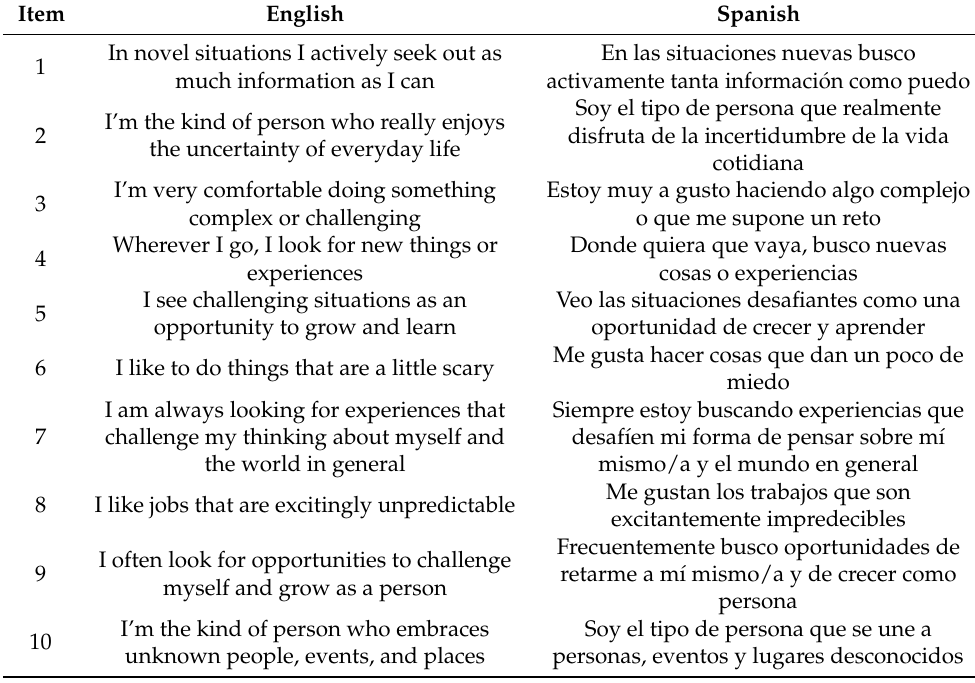
Table A1. Definition of CEI–II items in English and